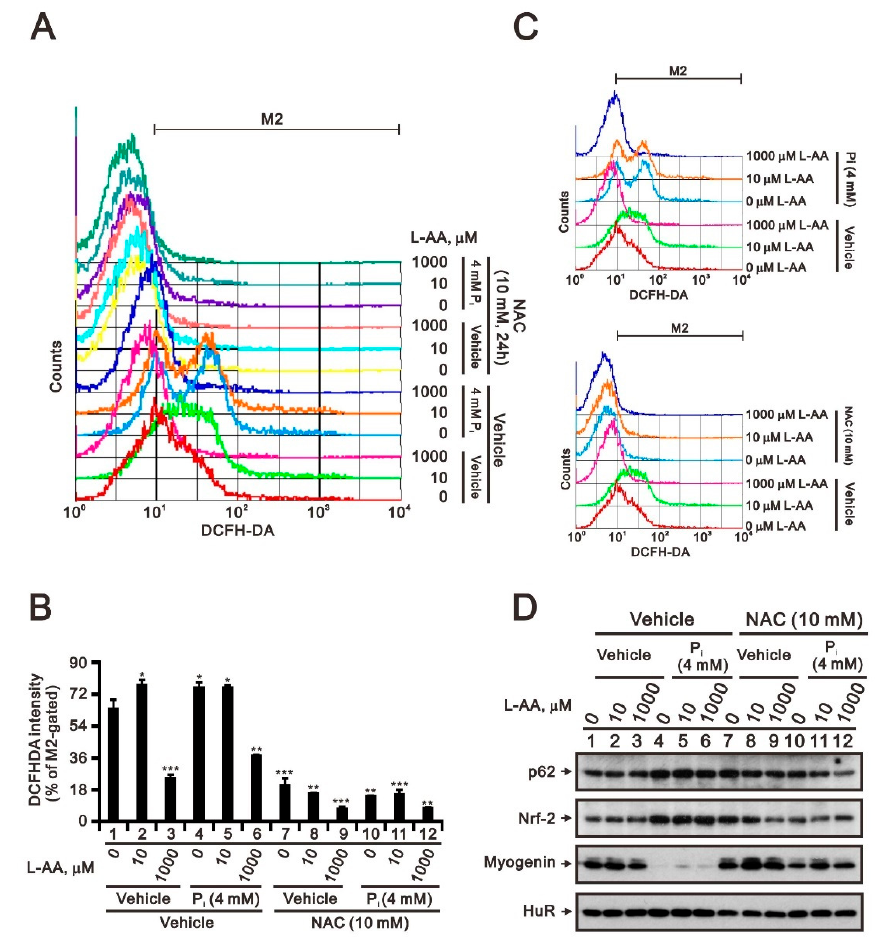
Figure 6. The effects of L-ascorbic acid on high P i -induced ROS generation in differentiated C2C12 cells. ( A ) Differentiated C2C12 cells were treated with the indicated concentrations of L-ascorbic acid (L-AA) combined with 5 mM NAC or 4 mM P i for 24 h. ( A , B ) Cytosolic ROS levels were determined based on H2DCFDA fluorescence using the FL1-H channel: the x-axis represents H2DCFDA intensity; the y-axis indicates the cell counts at the corresponding fluorescence intensity. Bars depict the mean ± SD. * p < 0.05; ** p < 0.01; *** p < 0.001. ( C ) Bar graph summarizing the data from panel A as percentages of cells with increased ROS production (% M2 gated). ( D ) Cell lysates were subject to immunoblot analysis against p62, Nrf2, and myogenin proteins. HuR was used as loading control.